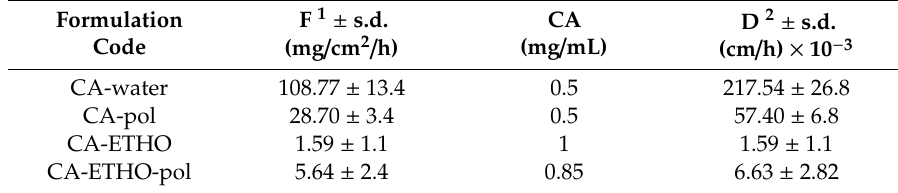
Figure 6. CA diffusion kinetics from CA-water (blue square), CA-pol (green open circle), CA-ETHO (black crosses), and CA-ETHO-pol (red closed circle), as determined by Franz cell. Data are the mean of six independent experiments. Table 4. Fluxes and diffusion coefficients of the indicated formulations.